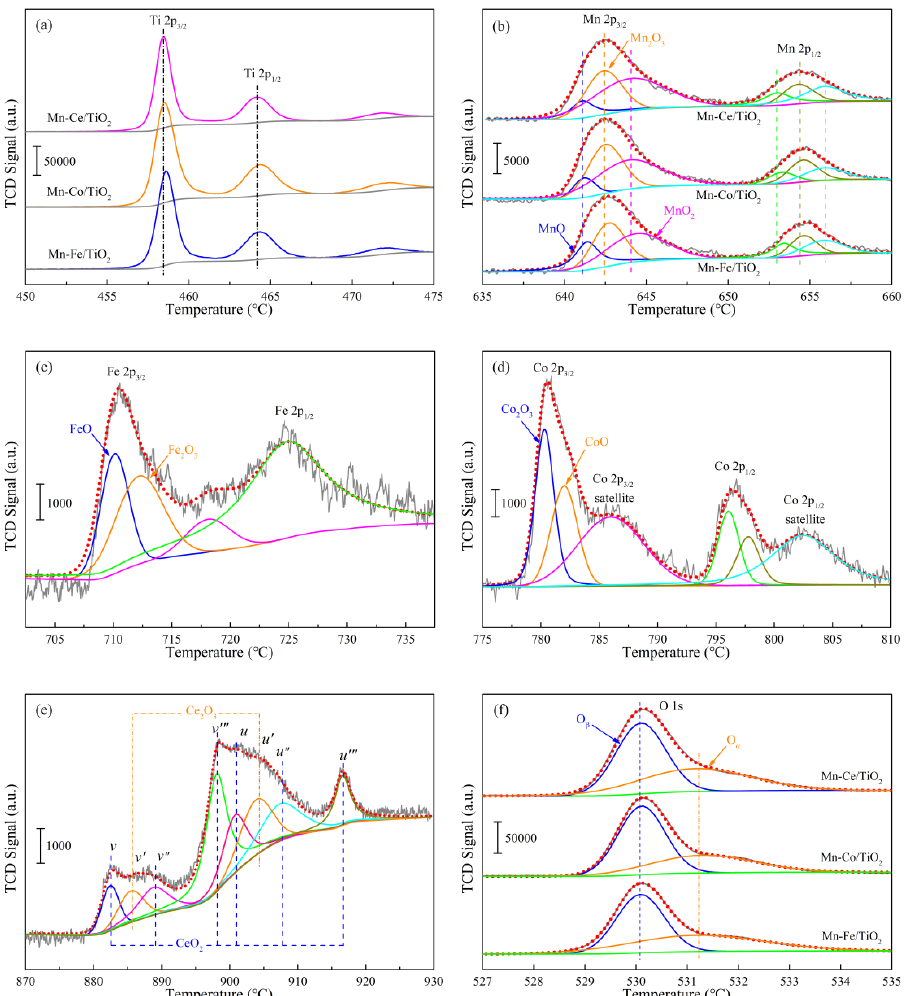
Figure 8. XPS analysis of Mn-based bimetallic nanocatsalysts: ( a ) XPS spectra for Ti 2 p ; ( b ) XPS spectra for Mn 2 p ; ( c ) XPS spectra for Fe 2 p ; ( d ) XPS spectra for Co 2 p ; ( e ) XPS spectra for Ce 3 d ; and ( f ) XPS spectra for O 1 s . Table 5. Surface atomic compositions of the catalysts determined by XPS.